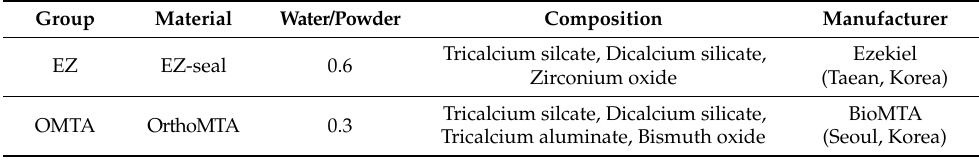
Table 1. Root canal filling materials used in this study.